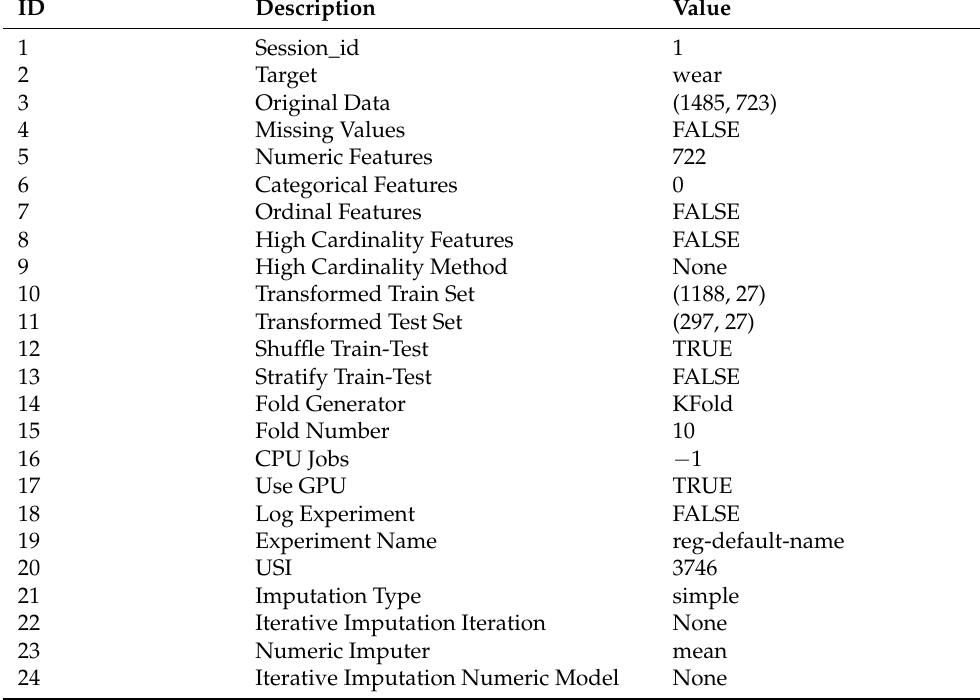
Table A2. Parameters for Automated Machine Learning (PyCaret version